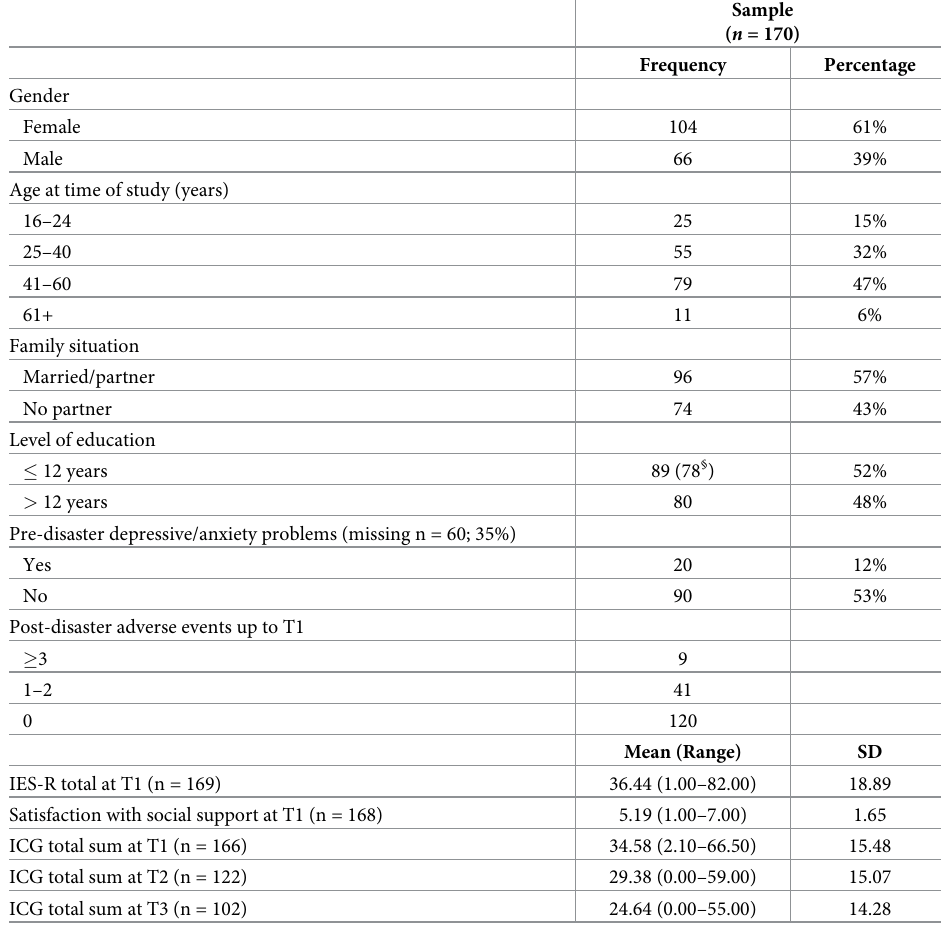
Table 1. Sample characteristics and mean scores on Inventory of Complicated